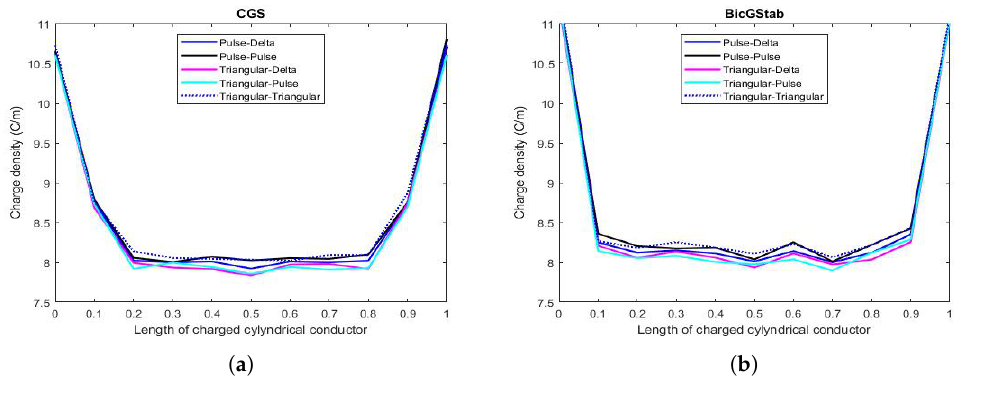
= 400 when ( a ) CGS and ( b ) BicGStab algorithms are d